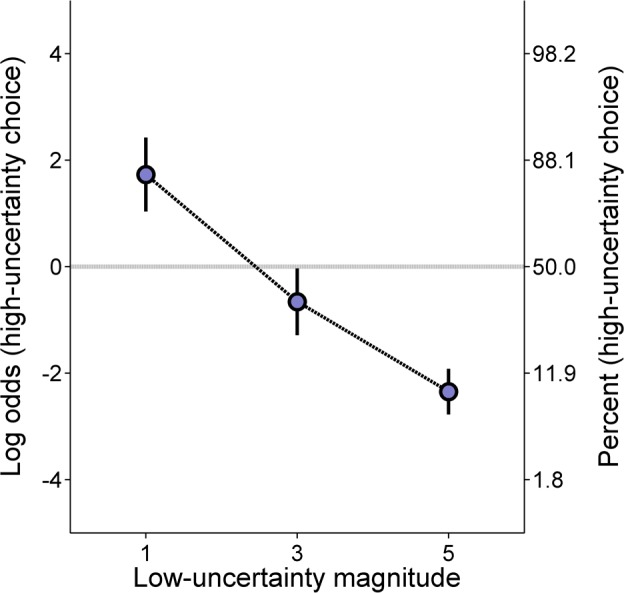
Mean (±SEM) log odds of high-uncertainty choices in the low-uncertainty magnitude training procedure of Experiment 3B as a function of the outcome magnitude of a low-uncertainty choice.A second ordinate showing percentages corresponding to the log odds values is included to aid interpretation.